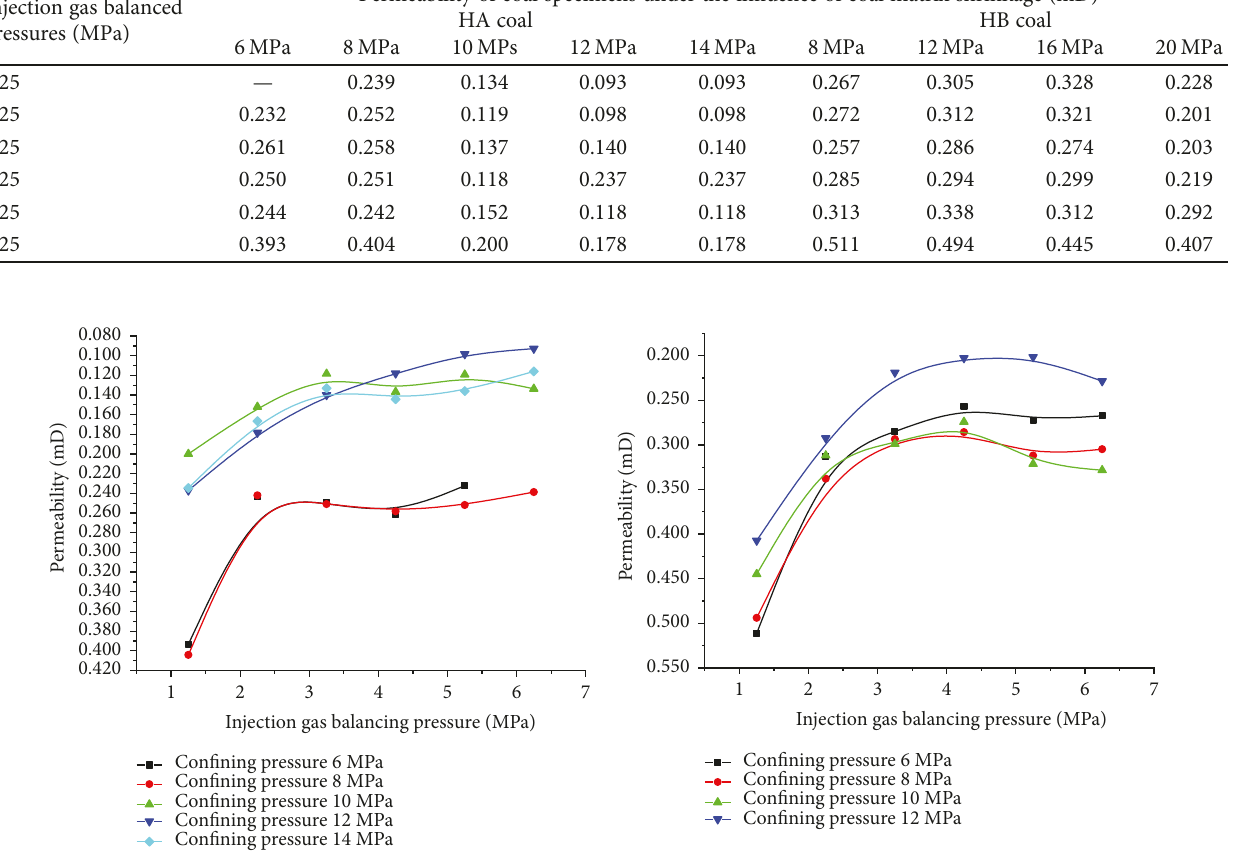
Table 4: Calculated results of permeability in fl uenced by coal matrix shrinkage under di ff erent con fi ning pressures. Injection gas balanced